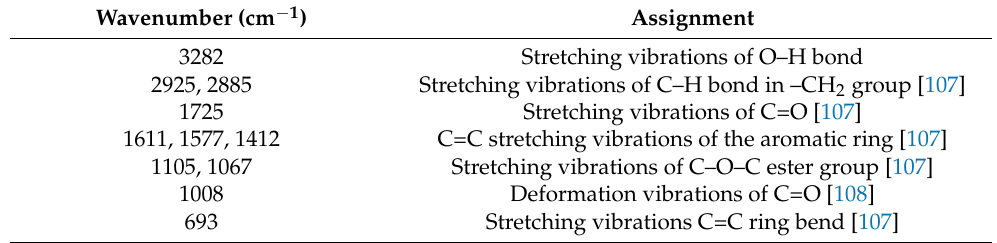
Table 2. Characteristic IR bands of doxorubicin and its conjugates with magnetite nanoparticles.